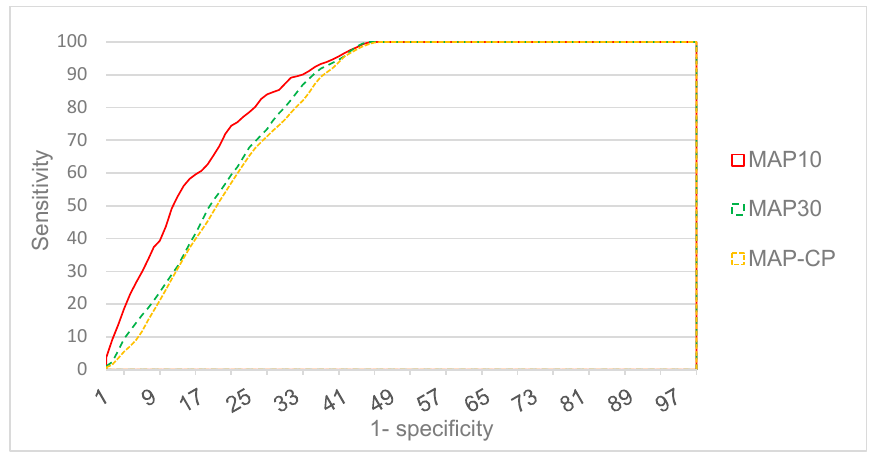
Figure 17. Area under the curve for evaluating the efficacy of the LSM by using recent landslides.